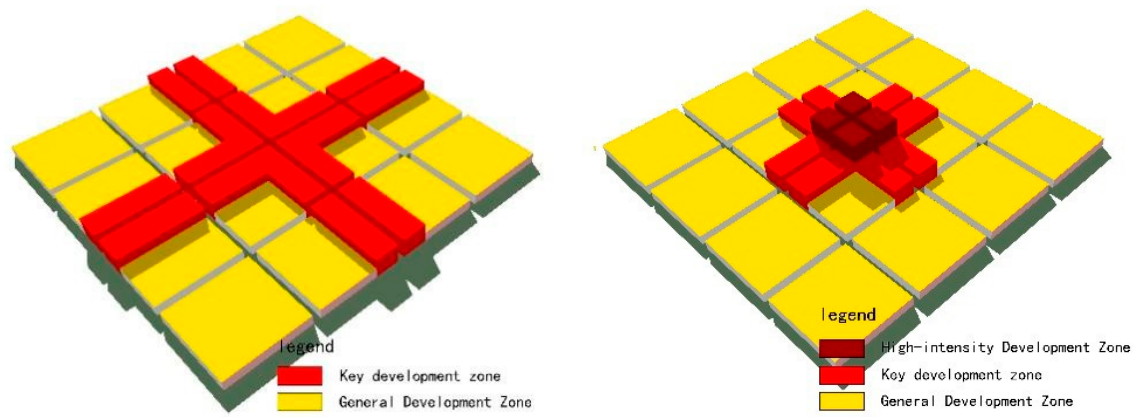
Figure 4. Schematic diagram of development intensity optimization.